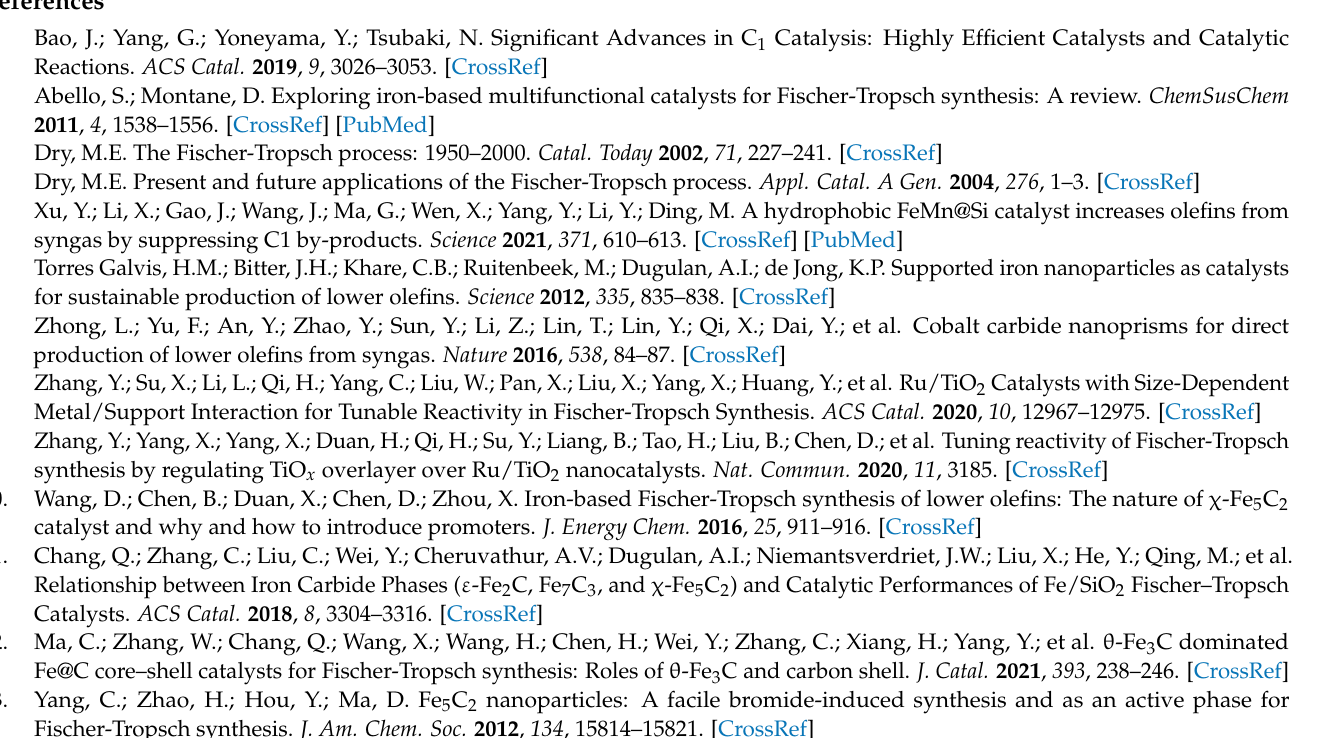
Figure S2: SEM images (a) precursor of 6 wt% Mn/Fe 3 C. (b,c) 6 wt% Mn/Fe 3 C sample; Figure S3: TEM elemental mapping images of 6 wt% Mn/Fe 3 C sample; Figure S4: N 2 physisorption isotherm of θ -Fe 3 C sample; Figure S5: N 2 physisorption isotherm of 6 wt% Mn/Fe 3 C sample; Figure S6: CO conversion and product selectivity of the 6 wt% Mn/Fe 3 C sample with the time on stream; Table S1: Textural properties, crystallite size, and manganese contents of